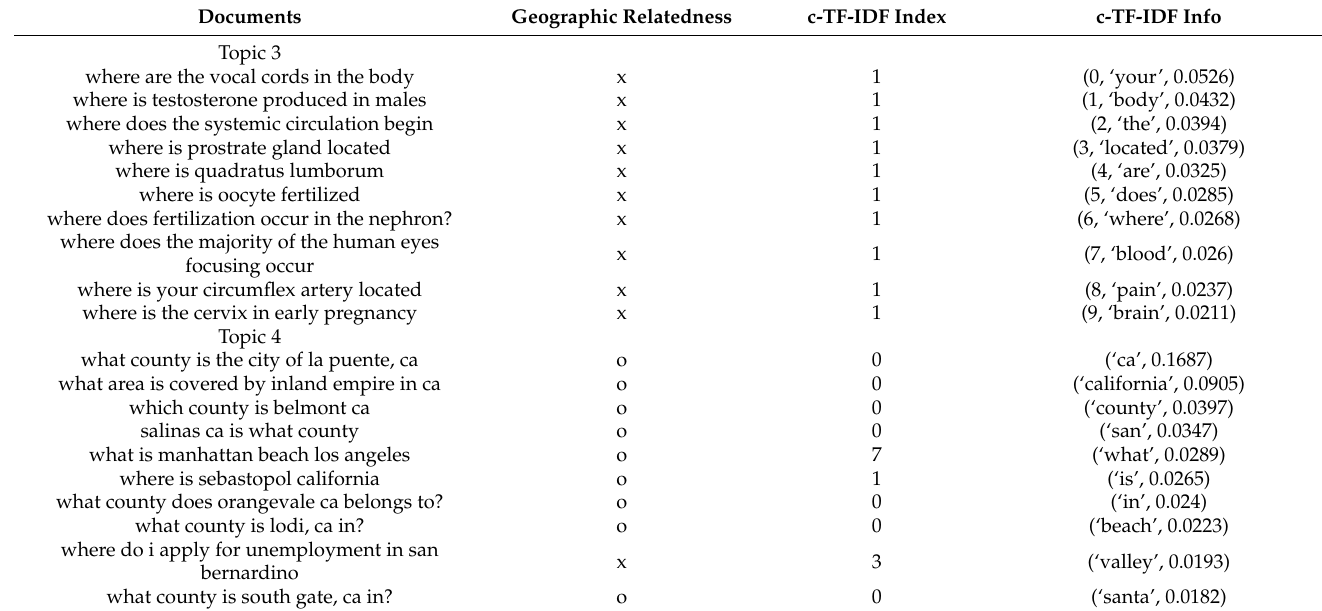
Table 14. Manual annotation example for topics 3, 4 regarding c-TF-IDF representativeness and geographic relatedness.